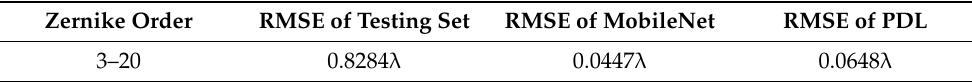
Figure 5. Comparison of the PSF image with 3–20 orders of Zernike polynomials (intensity reversed): ( a ) original distribution, ( b ) supervised learning recovery spots, and ( c ) self-supervised learning recovery spots. (The pixel size is 5.5 µ m and the image size is 256 × 256). Table 1. Comparison of accuracies (RMSE) of equivalent wave-fronts from the Zernike coefficients estimated in the experiments between PDL and MobileNet (3–20